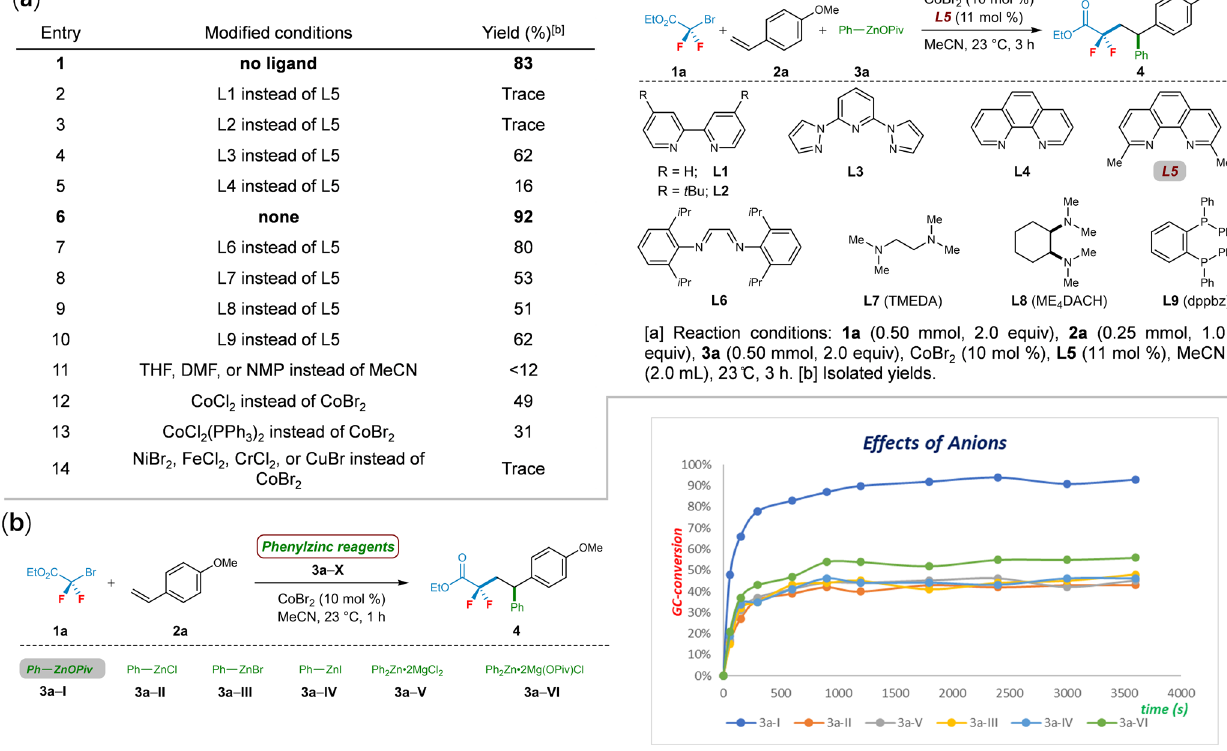
Fig. 2 Reaction optimization and reactivity of different arylzinc reagents. a Optimization for cobalt-catalyzed di fl uoroalkylarylation. b Kinetic experiments with different phenylzinc reagents of 3a ‒